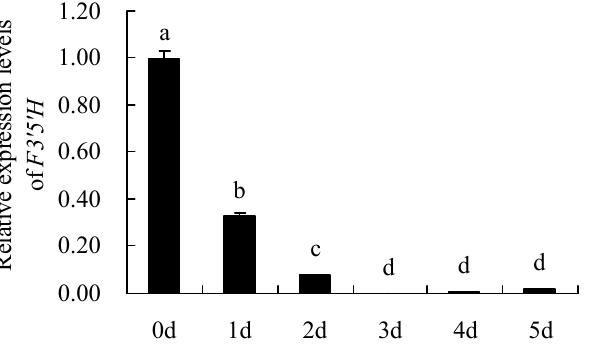
Figure 8. Relative expression levels of F3 ′ 5 ′ H gene. 0 d: the bud stage; 1 d: The petals of 1 day; 2 d: The petals of 2 day; 3 d: The petals of 3 day; 4 d: The petals of 4 day; 5 d: The petals of 5 day. Means